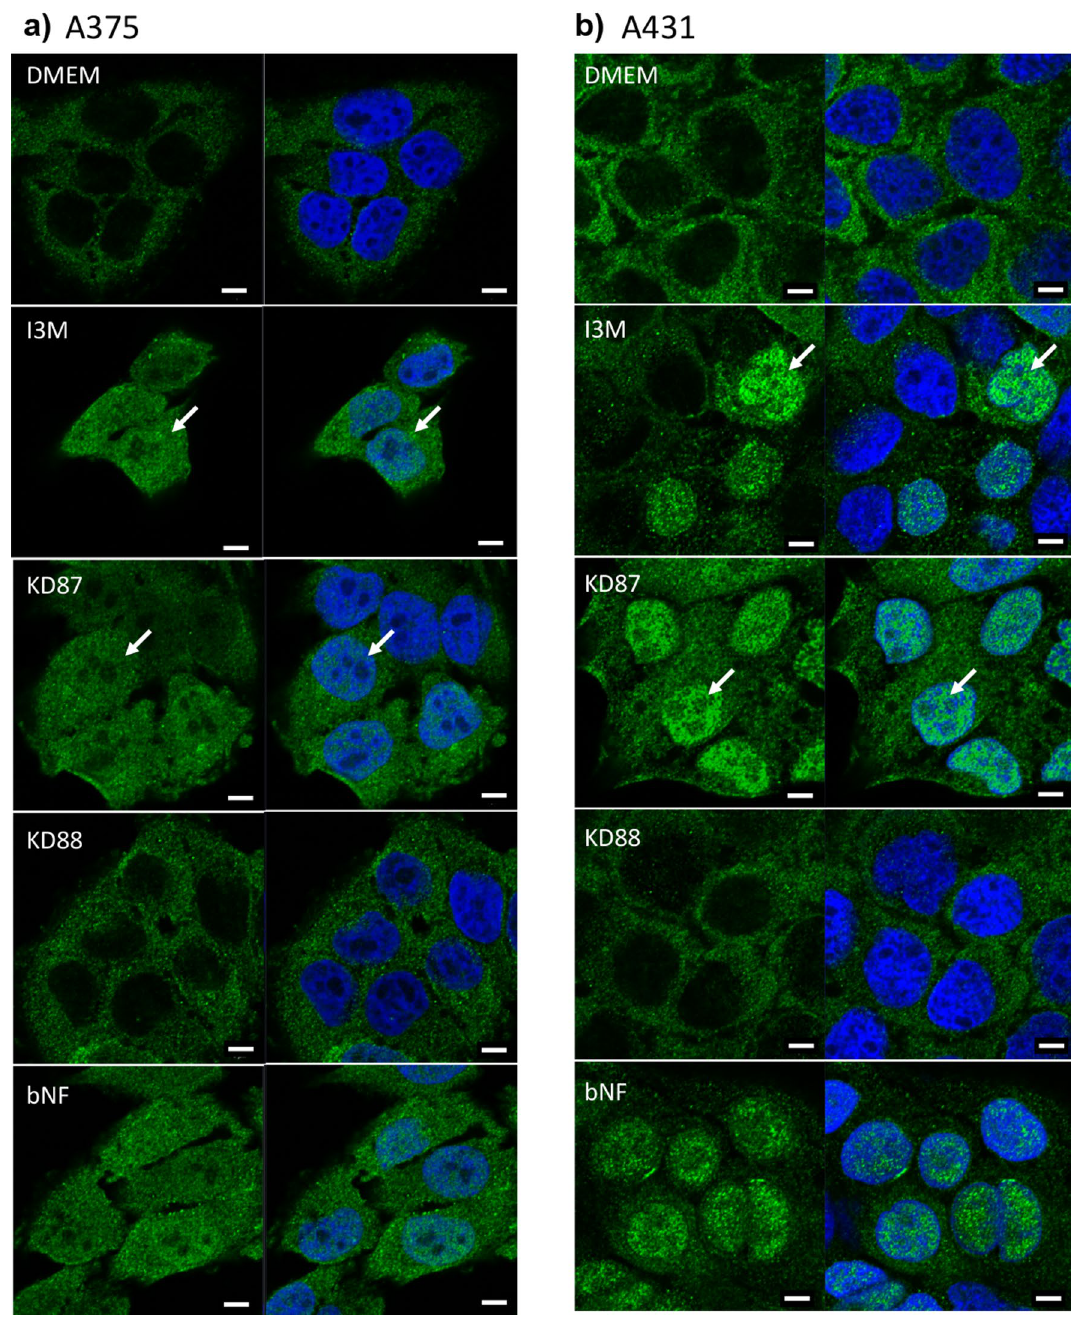
Figure 7. Localisation of the aryl hydrocarbon receptor (AhR, green) after 1 h stimulation with the indirubin derivatives (10 µM). In unstimulated cells (DMEM), the AhR was present in the cytosol. After stimulation with I3M and KD87 the AhR translocated (arrows) to the nucleus (blue). ß-Naphthoflavone (bNF, 20 µM) was used as positive control for AhR-translocation (LSM 780, bars: 5